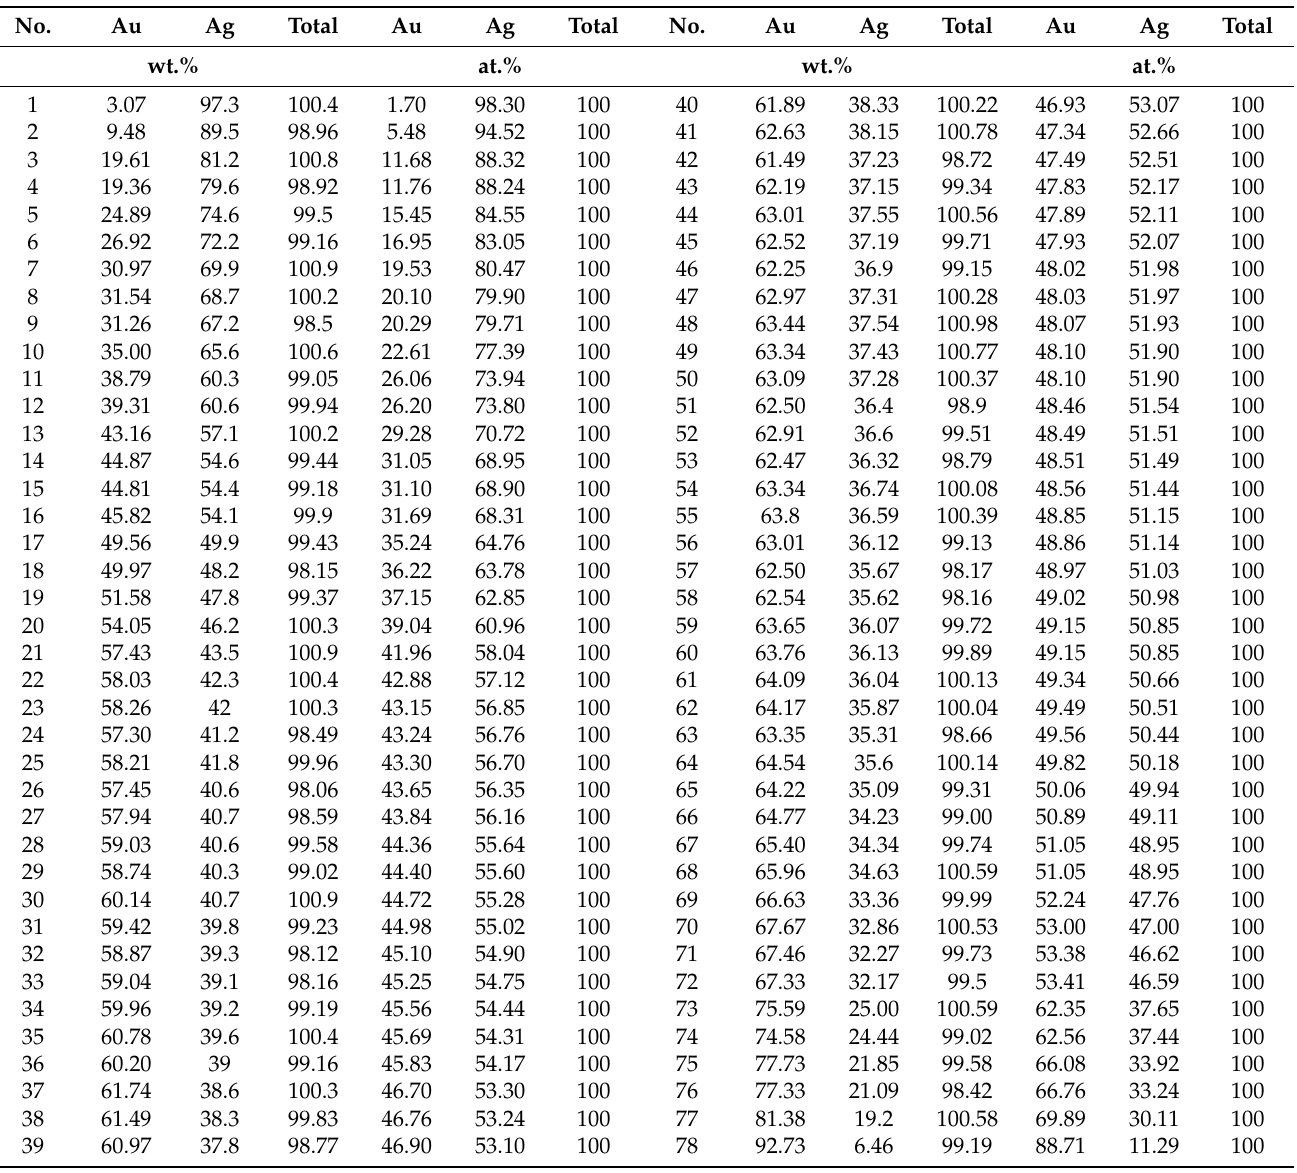
Table 3. Composition of some representative Au-Ag alloys of the Rodnikovoe